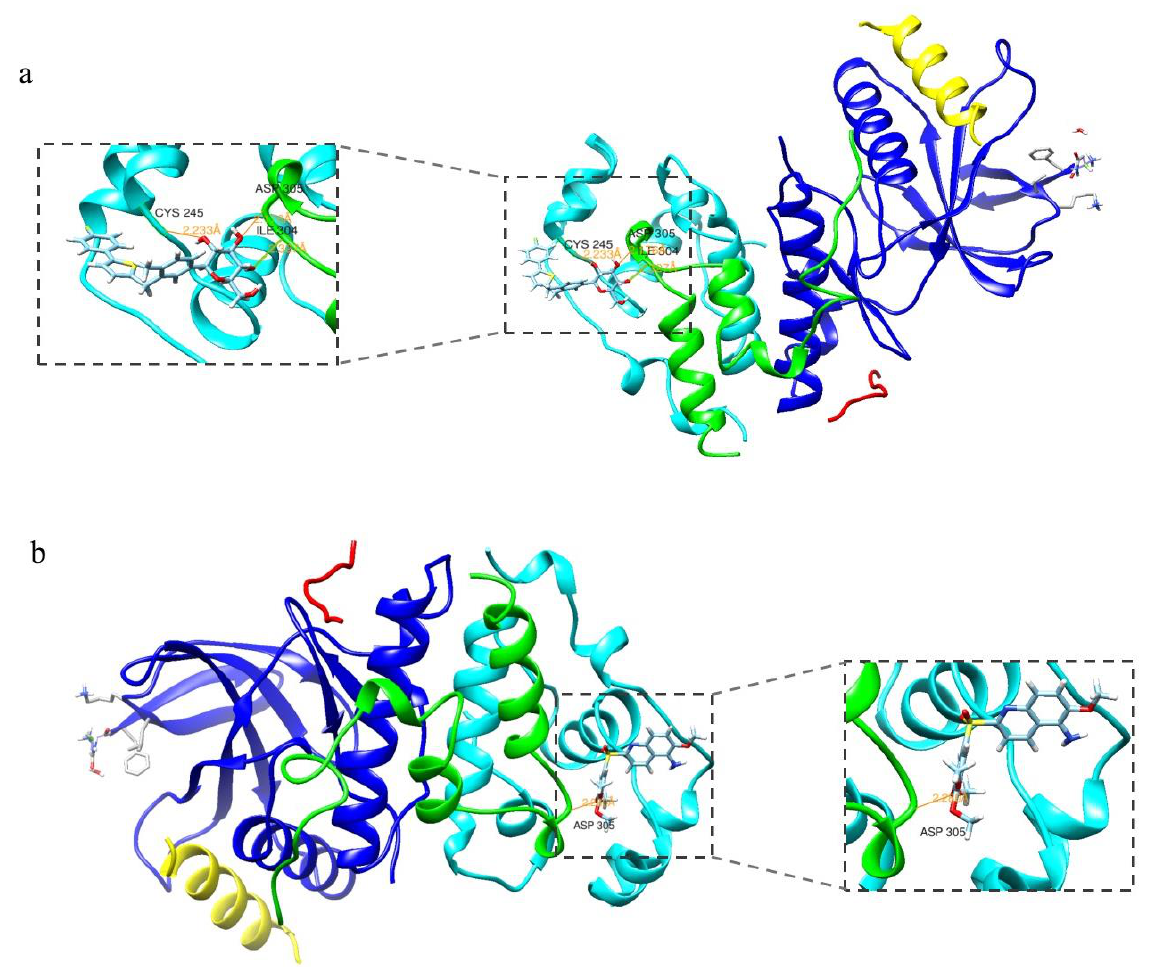
Figure 1. Molecular docking results for p38 with canagliflozin and the positive drug. ( a ) Docking results for p38 and canagliflozin. ( b ) Docking results for p38 and the positive drugs.